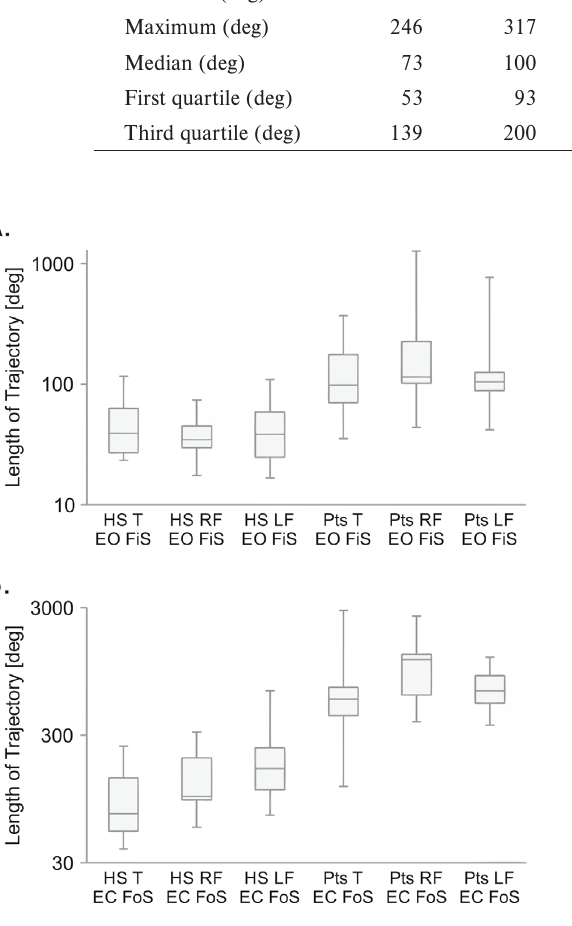
Figure 3. Comparison of the length of the trajecto- ries of trunk (T), right foot (RF) and left foot (LF) of healthy subjects (HS) and patients (Pts) standing on a firm surface (FiS) with eyes open (EO) and foam sur- face (FoS) with eyes closed